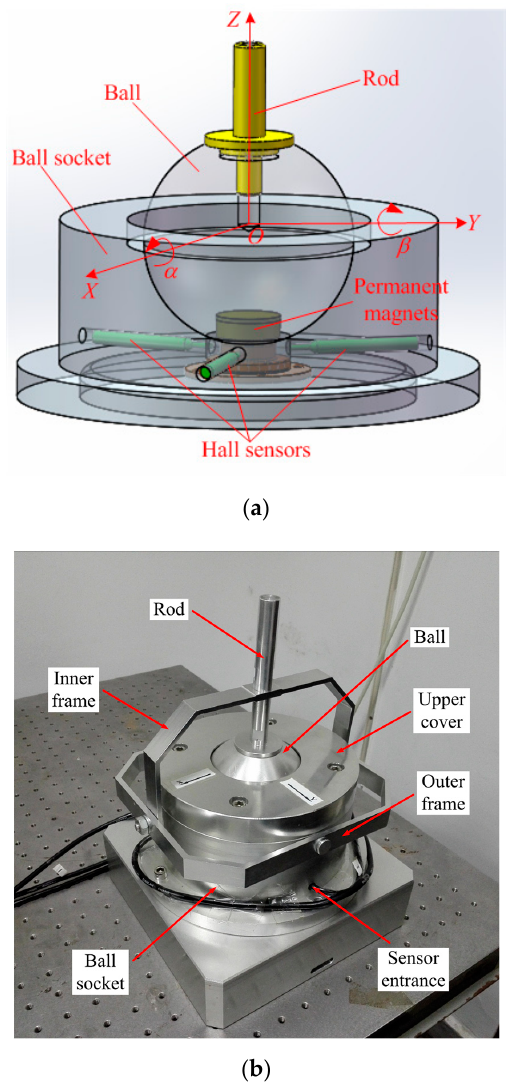
Figure 1. The prototype of intelligent ball joint. ( a ) Schematic diagram of intelligent ball joint; ( b ) photo of intelligent ball joint.